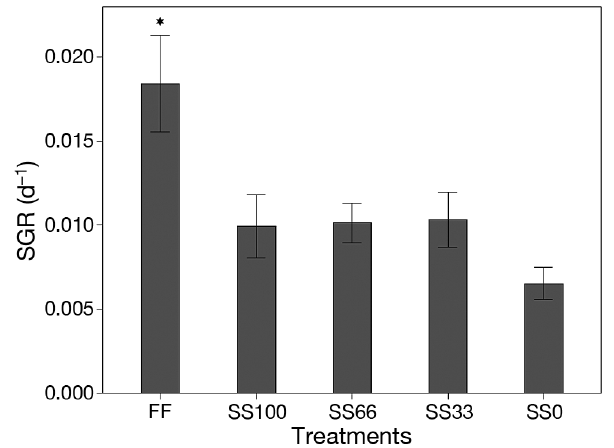
Fig. 1. Specific growth rate (SGR, d −1 ) of Hediste diversicolor fed with different diets (see Table 1 for treatment defini- tions). Data are mean ± SD.* indicates significant difference at α = 0.05